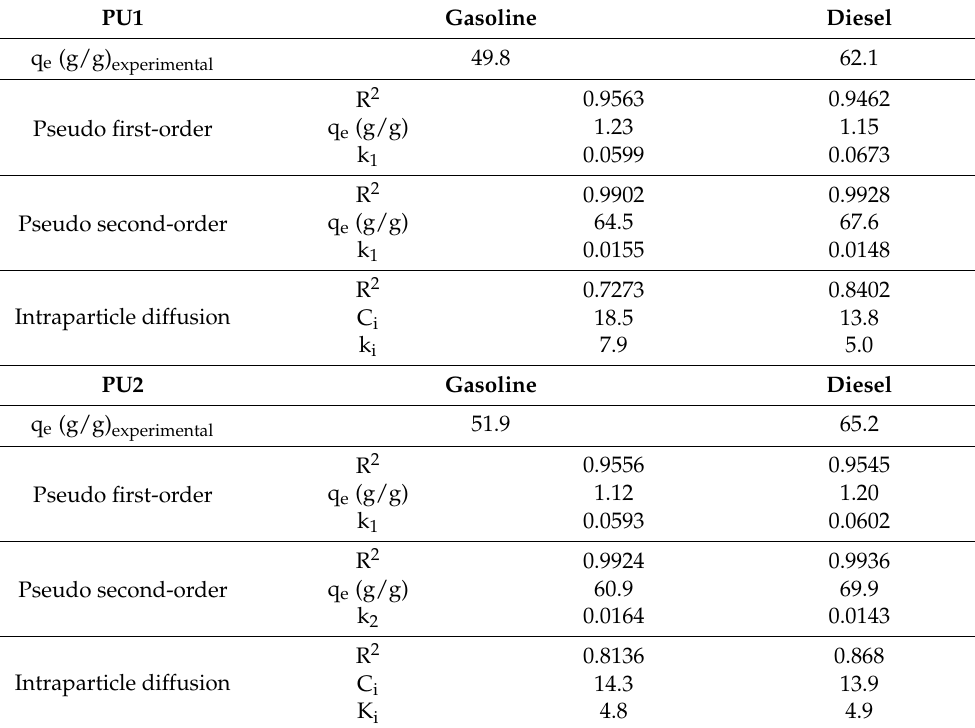
Table 2. Maximum oil sorption capacities at equilibrium, rate constants and correlation coefficients evaluated at 25 ◦